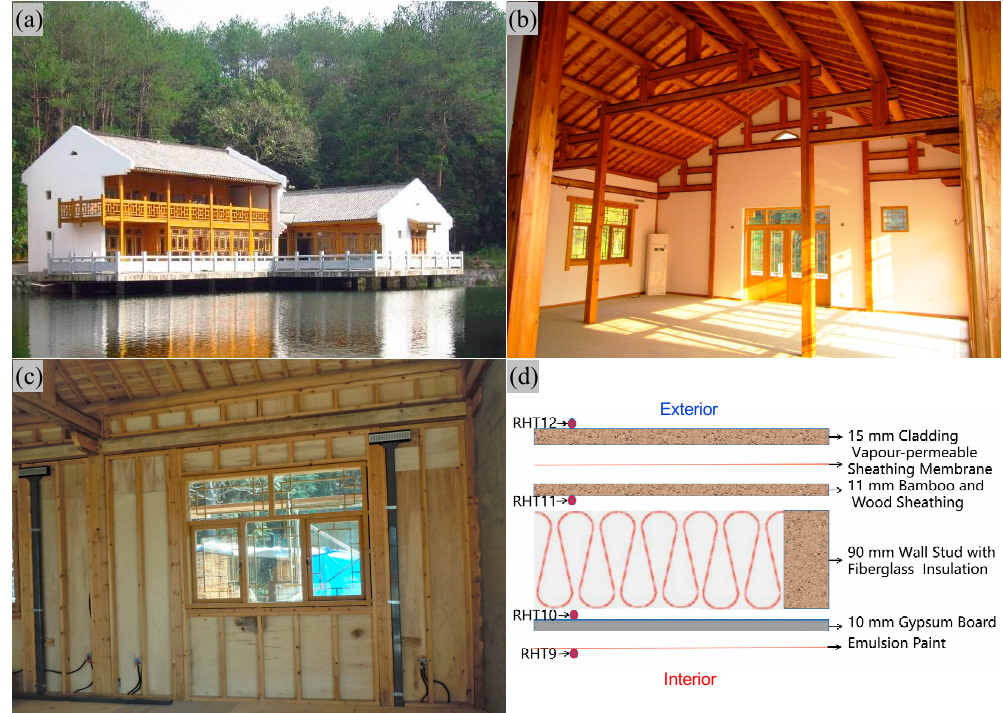
Figure 1. Test building and wall configuration: ( a ) the Hui-style demonstration building for the test; ( b ) indoor scene of beam and post structure; ( c ) stud and bamboo-wood sheathing; ( d ) configuration and materials. (The pictures in ( a – c ) were taken by X.W.; ( d ) was drawn by H.L.). Wall assemblies were constructed with 40 mm × 90 mm Chinese fir lumber